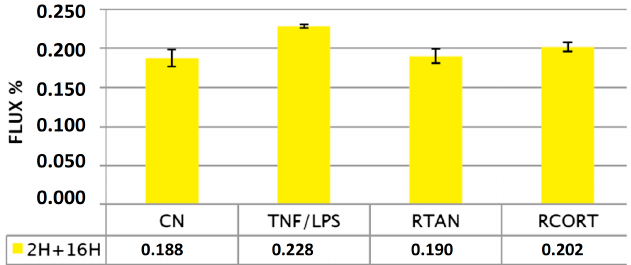
Figure 3. Preservation of paracellular flux by Rhinosectan ® between the apical and basolateral compartments of MucilAir. Preservation of paracellular flux reflects the integrity of the mucosal barrier. Lucifer yellow (LY) permeability after 2 h of pre-treatment with Rhinosectan ® (30 µL) and 16 h of exposure to pro-inflammatory compounds (LY flux (%) values). LY Flux = (RFUbl/RFUap) × 100, where RFUbl are fluorescent units detected at the basolateral compartment and RFUap are units detected at the apical part compartment. CN: negative control (pre-treatment with saline solution), without presence of pro-inflammatory compounds; TNF/LPS: pre-treatment with saline solution and exposure to pro-inflammatory compounds (TNF- α 500 ng/ml plus LPS from Pseudomonas aeruginosa 10, 0.2 mg/mL); RTAN: pre-treatment with Rhinosectan ® (30 µL) and 16 h of exposure to pro- inflammatory compounds; RCORT: pre-treatment with Rhinocort ® spray (budesonide) (30 µL) and 16 h of exposure to pro-inflammatory compounds